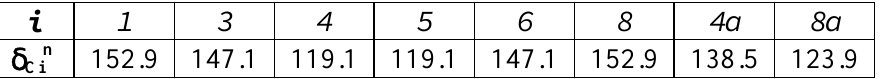
Table 4. Substituent increments for carbon NMR spectra of the one-ring substituted 2,7-naphthyridines